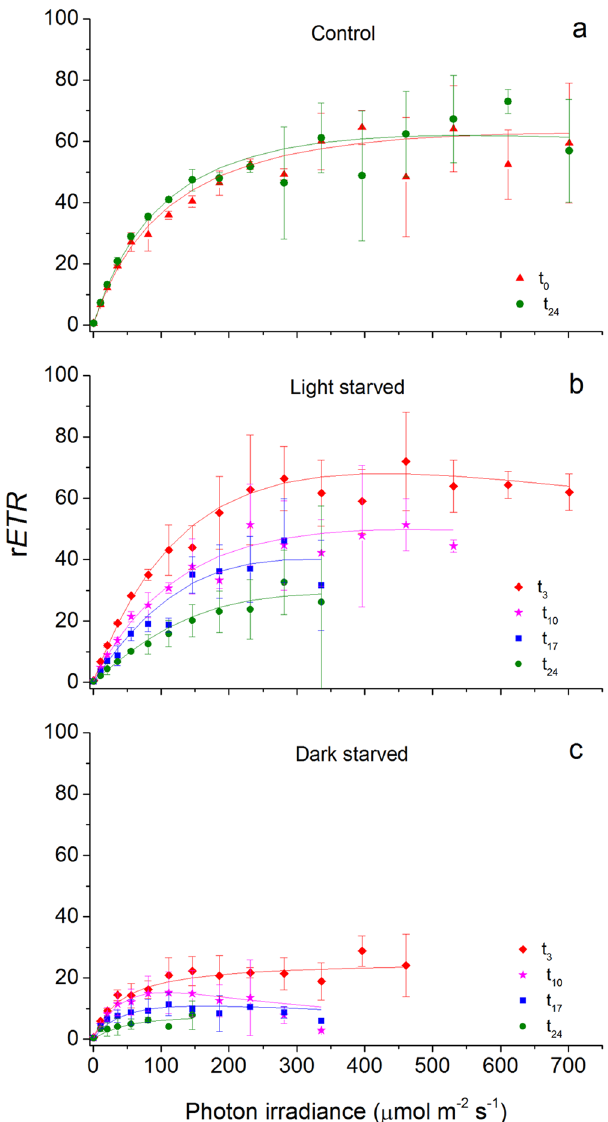
Figure 2. Rapid light-response curves of relative electron transport rate (r ETR ) vs. photon irradiance in Elysia viridis . r ETR (mean ± standard deviation, n = 3) of animals feeding on Codium tomentosum (control, a ), starved under a 14:10 h light:dark cycle (light-starved, b ), and continuous darkness (dark-starved, c ). The number of treatment days is represented as t days . Lines represent curve fits according to the model of Eilers and Peeters